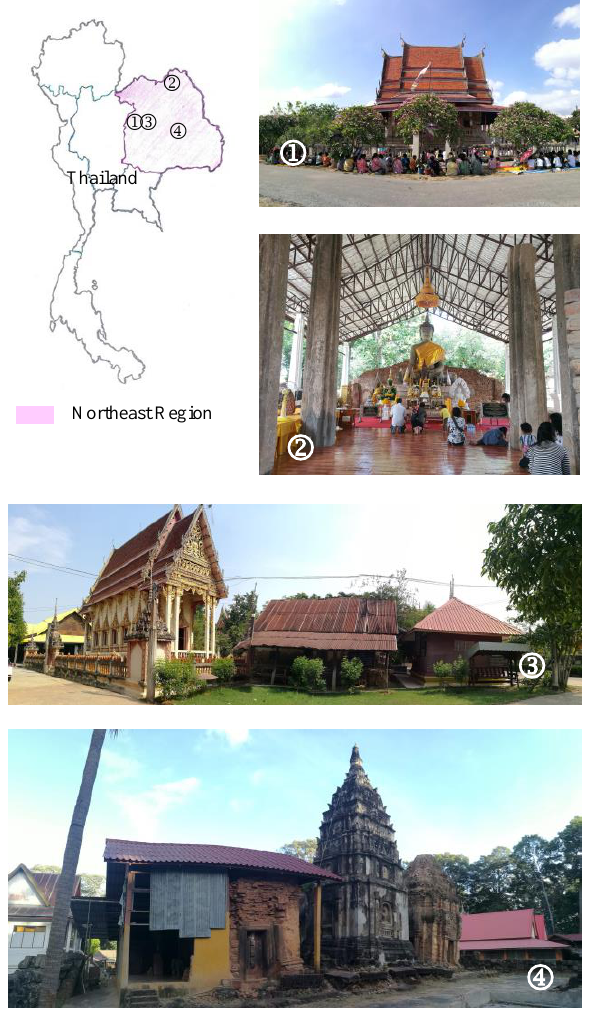
Figure 2. Locations and existence of the four